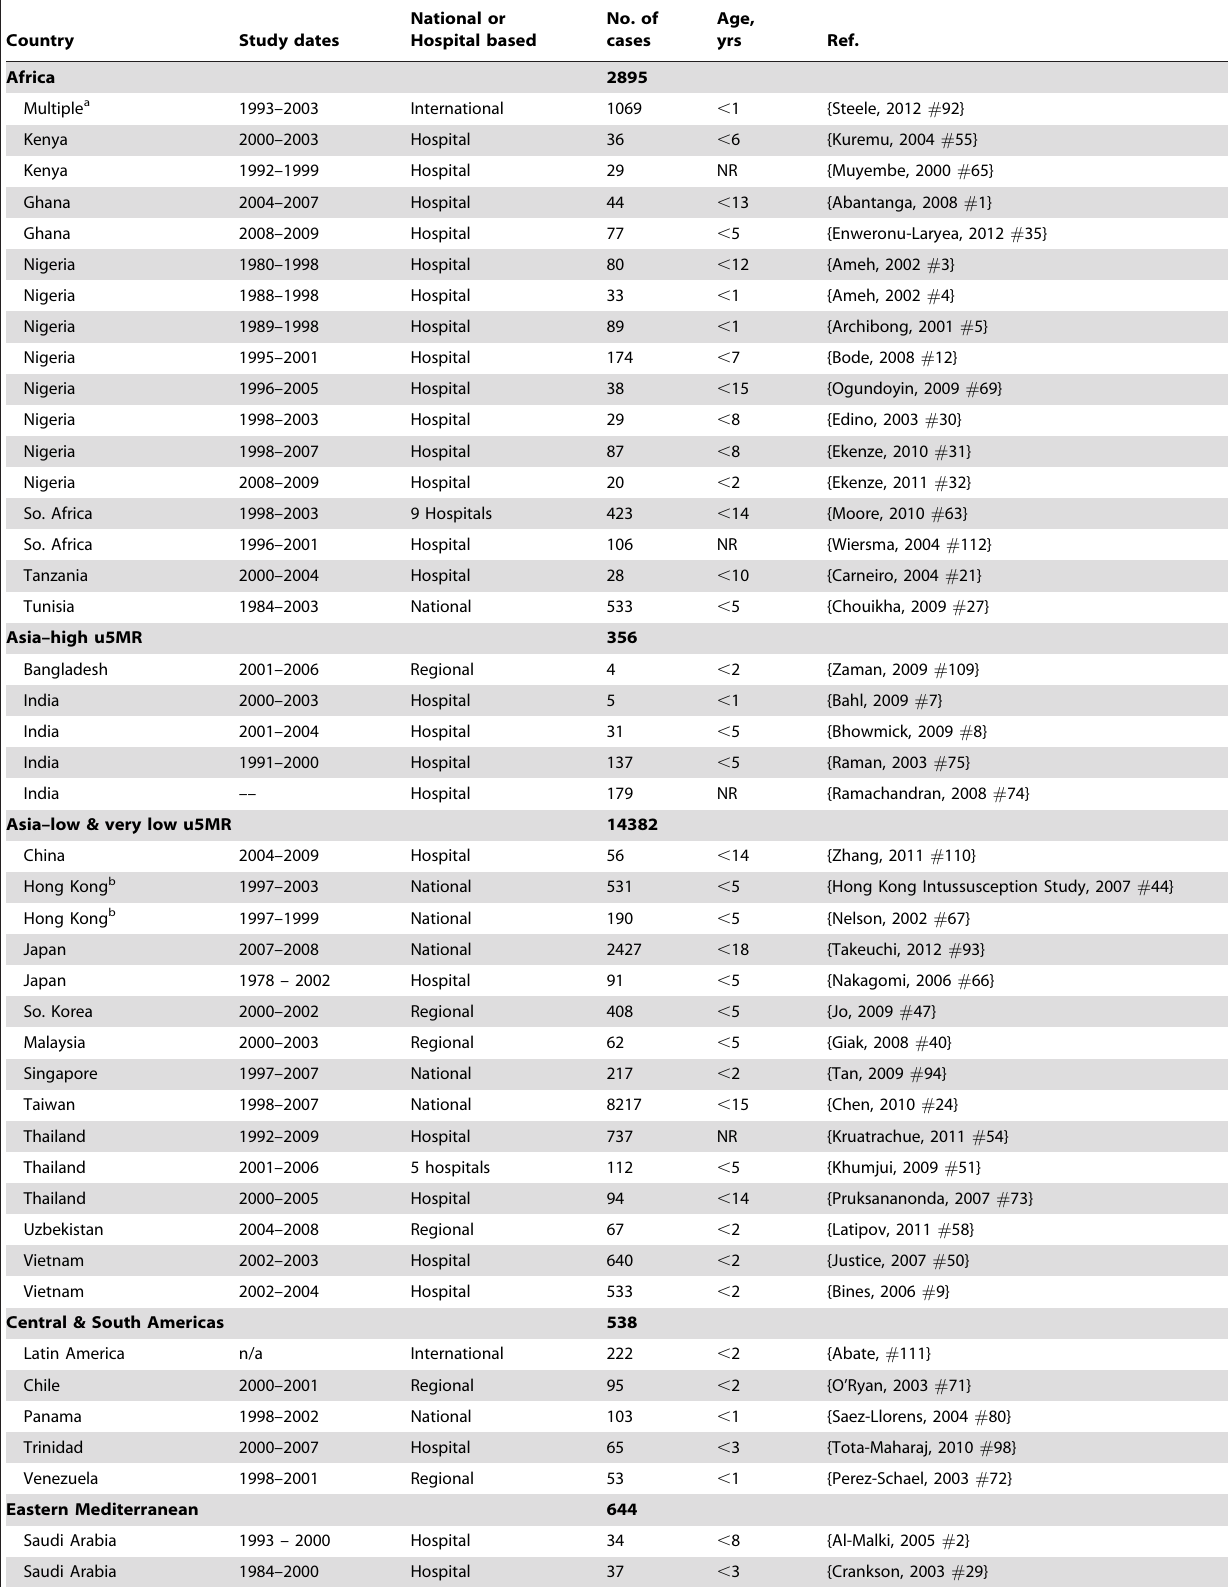
Table 1. List of all included studies.